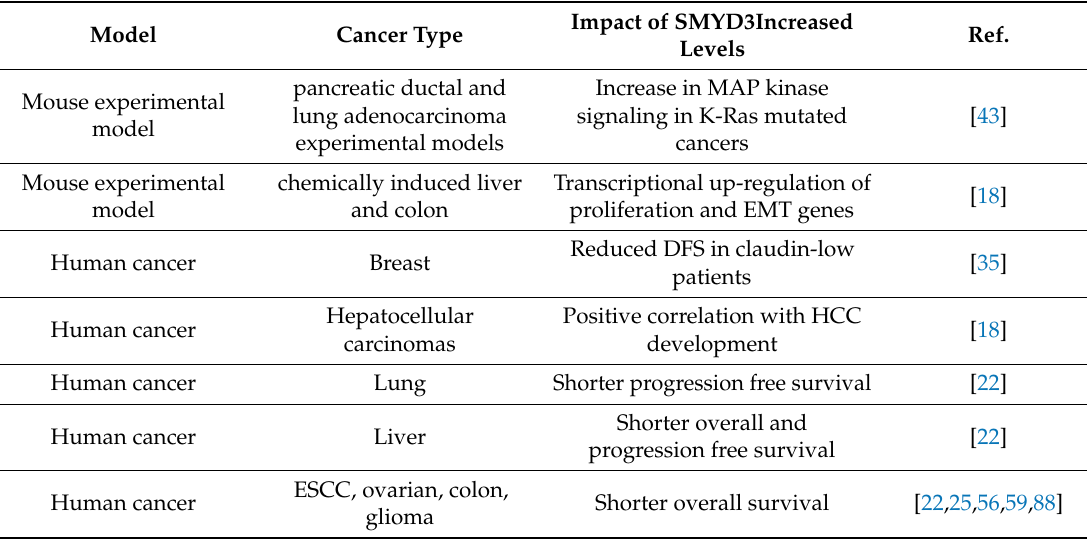
Table 3. Summary of SMYD3 roles in cancer in